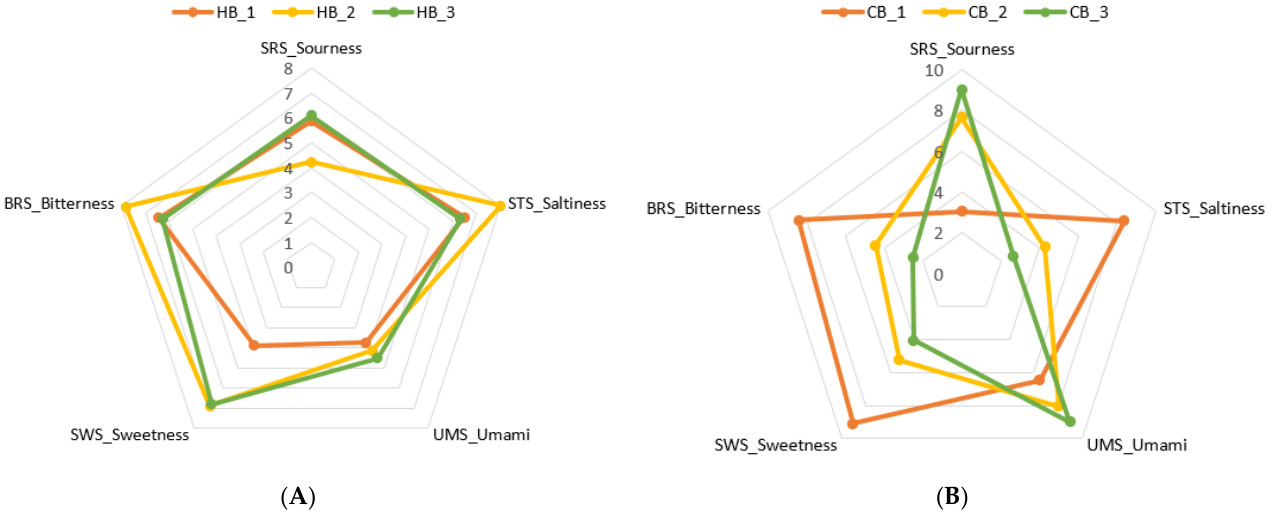
Figure 3. Spider chart for the taste profile of hot beverages ( A ) and a spider chart for the taste profile of cold beverages ( B ). HB_1, hot beverage 0.8 g/100 mL; HB_2, hot beverage 2 g/100 mL; HB_3, hot beverage 4 g/100 mL; CB_1, cold beverage 25 g/L; CB_2, cold beverage 50 g/L; CB_3, cold beverage 75 g/L.